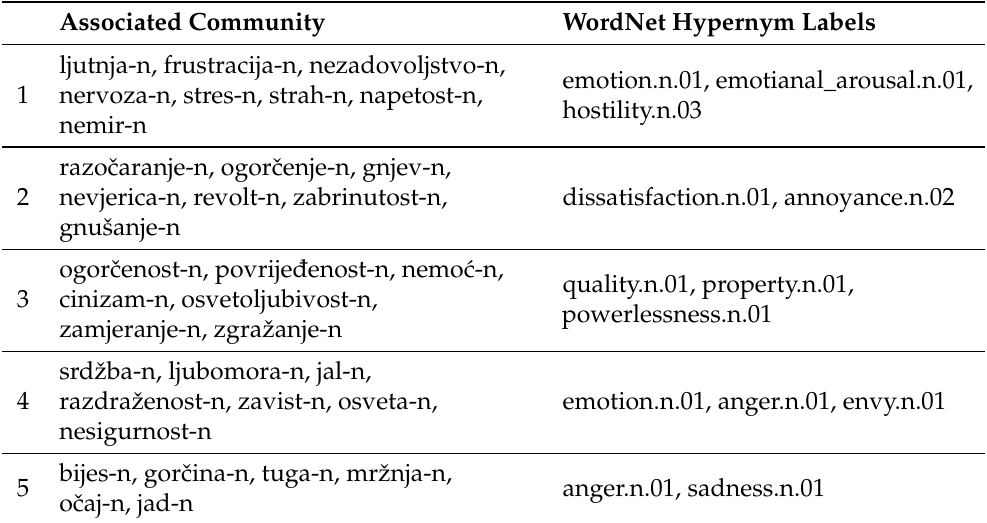
of the i hypernym ljutnja